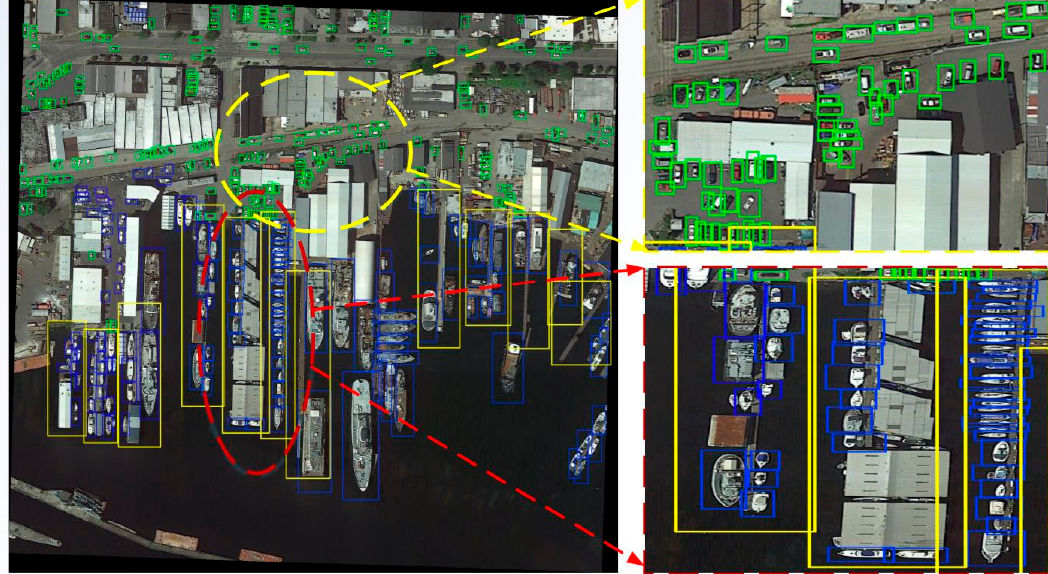
Figure 8. Results of our Network for three categories of objects (ship, building, car).